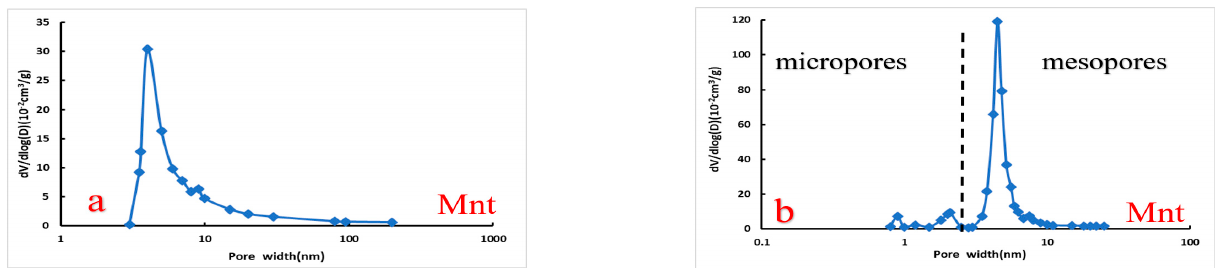
Figure 7. Average equivalent heat of adsorption at different pore sizes.